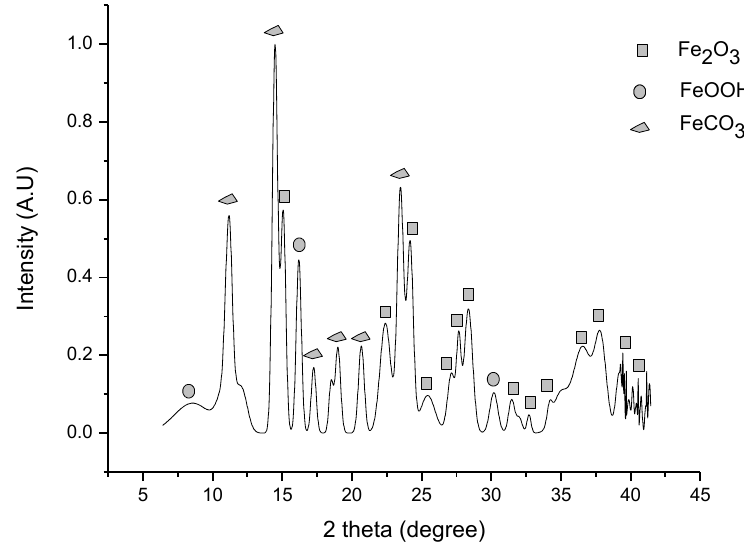
Figure 4. Carbonation of iron ore in ball milling at 30 bar, 400 rpm, 32 ◦ C, and 20 h of reaction time.